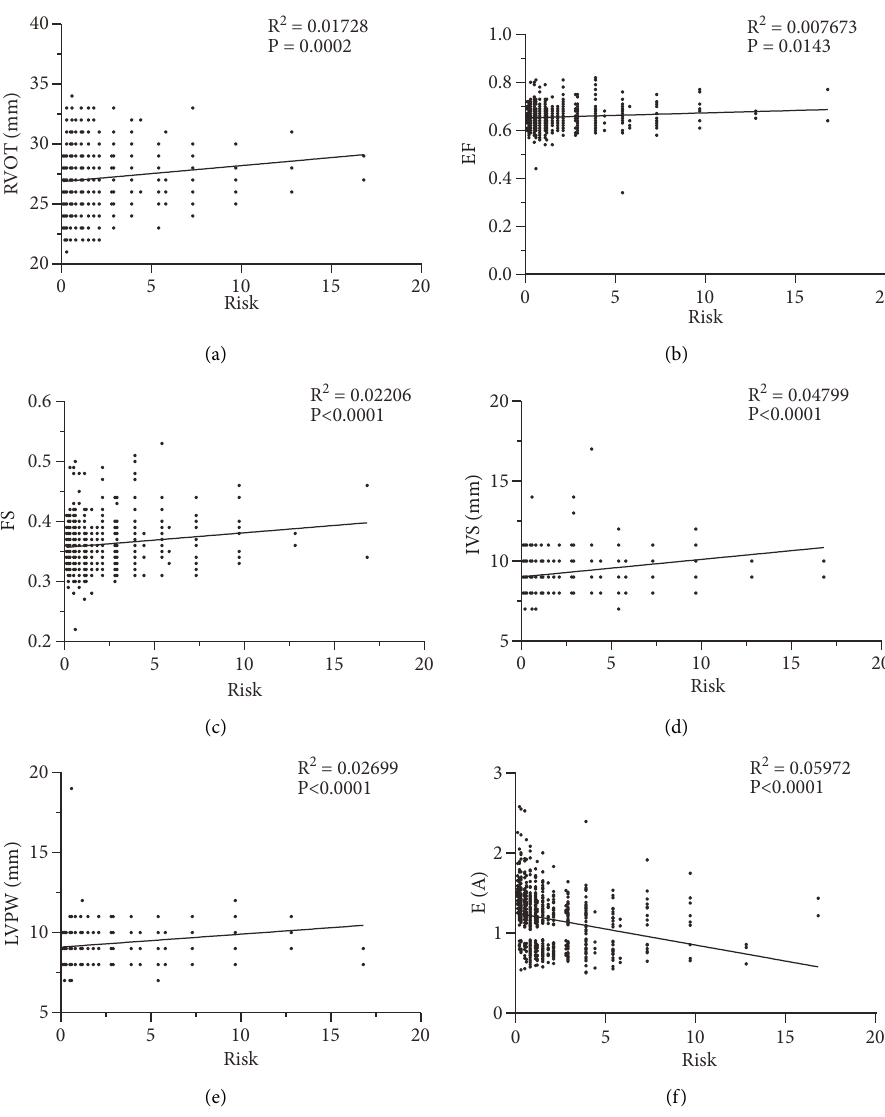
Figure 6: Correlation of cardiac ultrasound parameters with cardiovascular risk. (a) Right Ventricular Outflow Tract (RVOT). (b) Ejection Fraction (EF). (c) Fractional shortening (FS). (d) Interventricular septum (IVS). (e) Left ventricular posterior wall (LVPW). (f) E/A